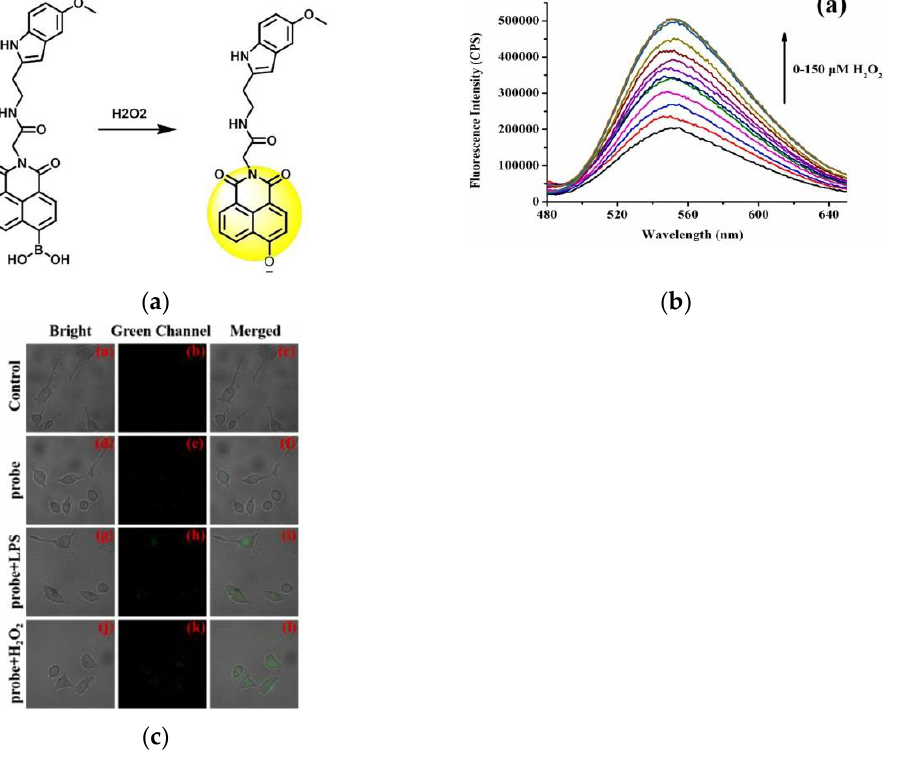
Figure 32. ( a ) Mechanism of the probe activation by H 2 O 2 ; ( b ) Fluorescence responses of probe NH-MT toward different concentrations of H 2 O 2 ; ( c ) Fluorescence imaging in HepG2 cell. Reproduced with permission from [138]. Copyright 2021 Elsevier B.V.